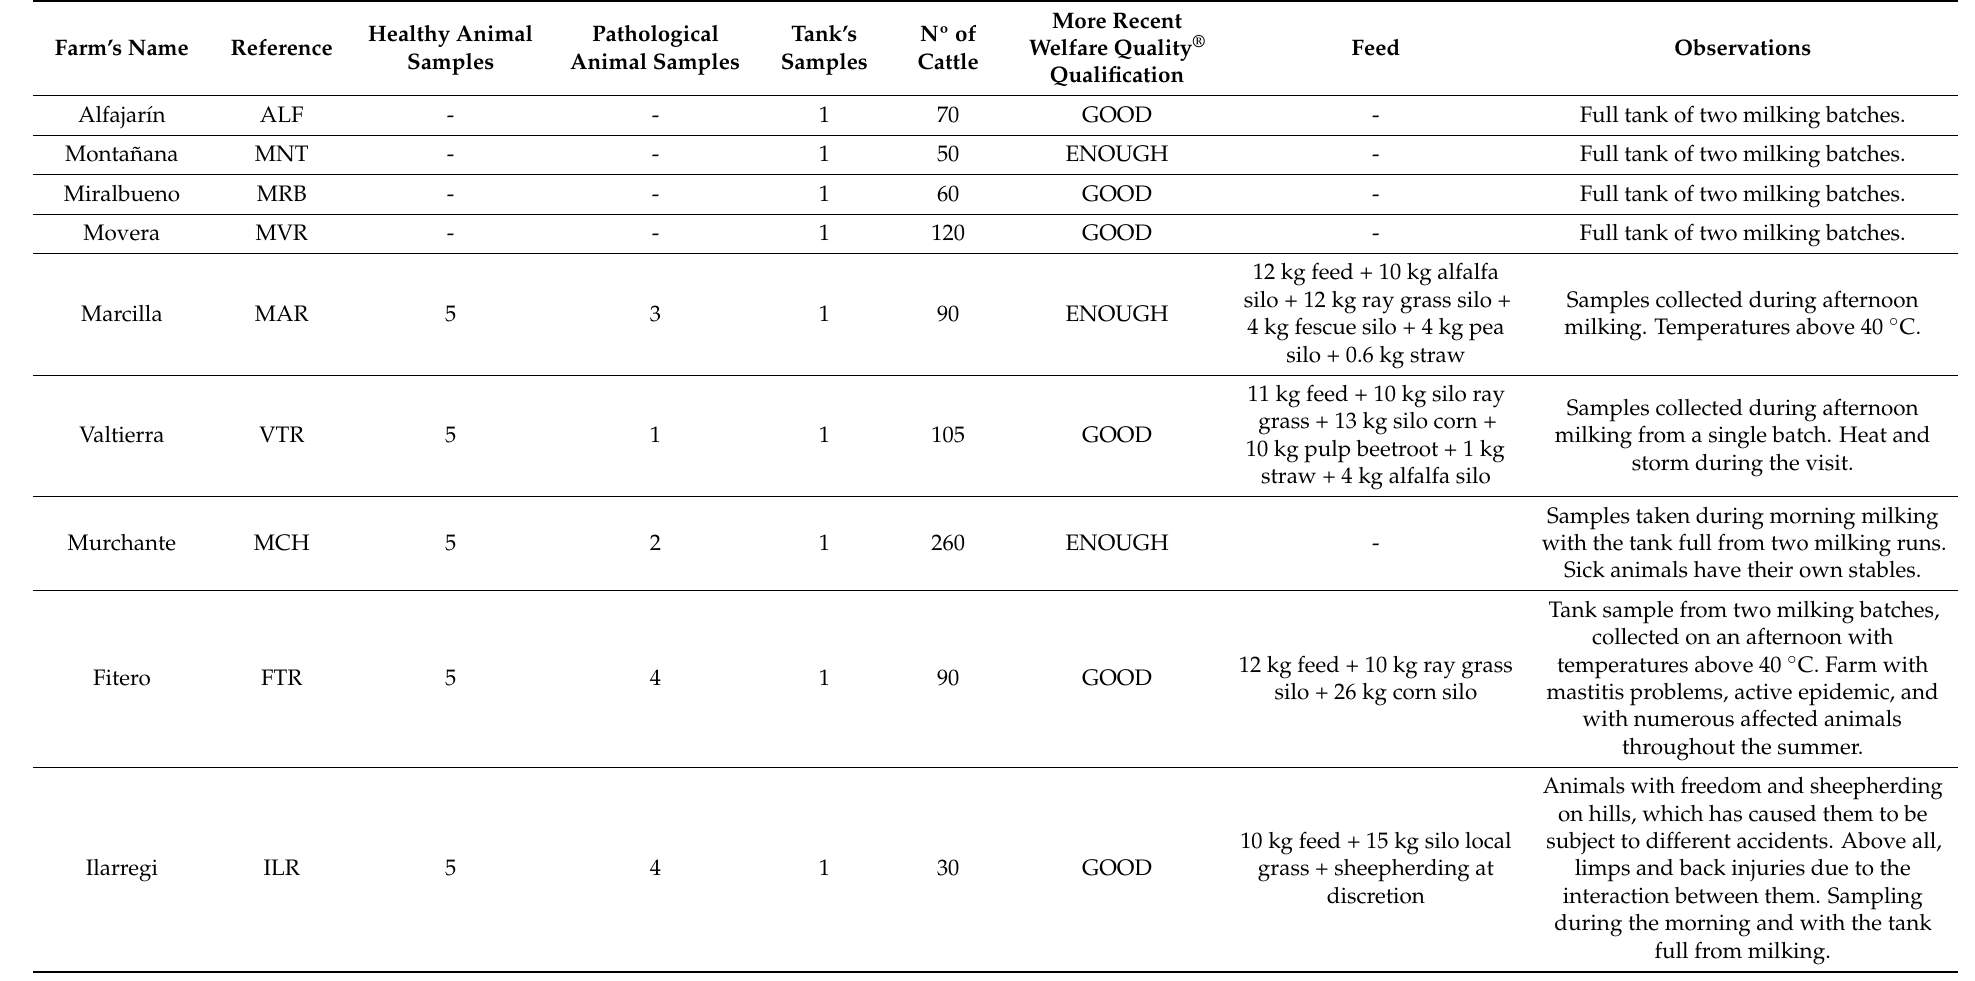
Table A3. Summary of the data obtained from the farms on which the samples were